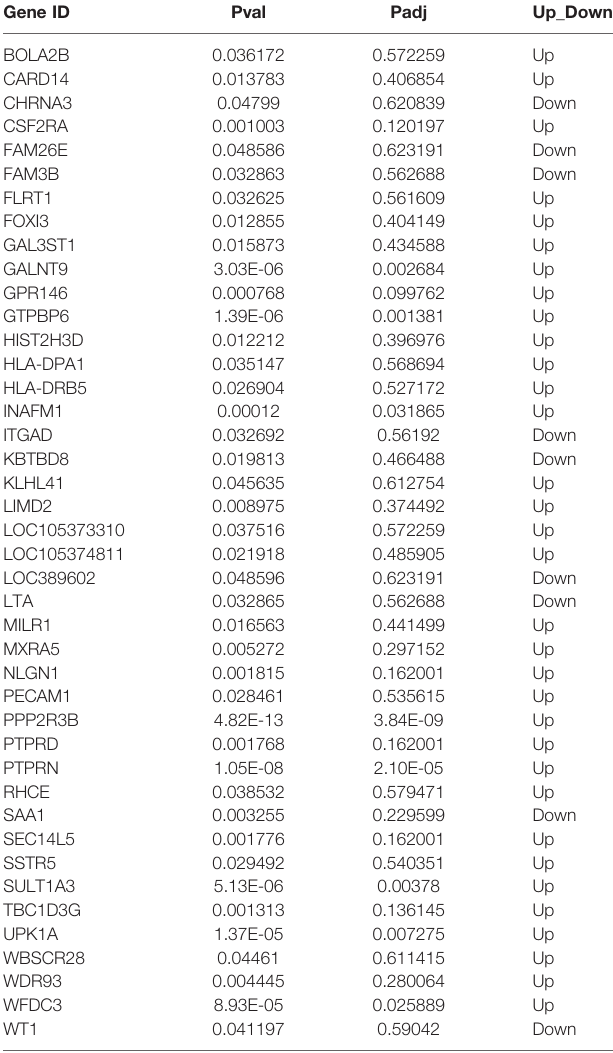
TABLE 5 | The list of differentially expressed